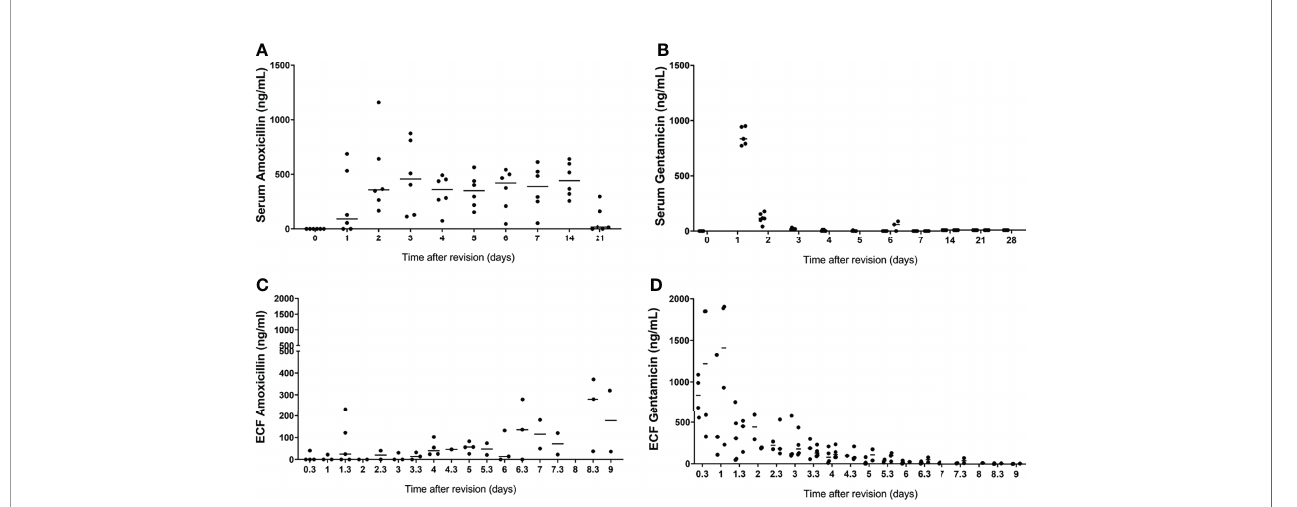
FIGURE 3 | Serum and extracellular fl uid amoxicillin ( A, C , respectively) and gentamicin ( B, D , respectively) concentrations from sheep that received the gentamicin- loaded hydrogel. Extracellular fl uid was collected by ultra fi ltration from the intramedullary canal of the tibia in the morning and afternoon, after application of the gentamicin-loaded hydrogel in both models. Serum was collected daily for 7 days and weekly thereafter after application of the gentamicin-loaded hydrogel in both groups. Lines represent median values.